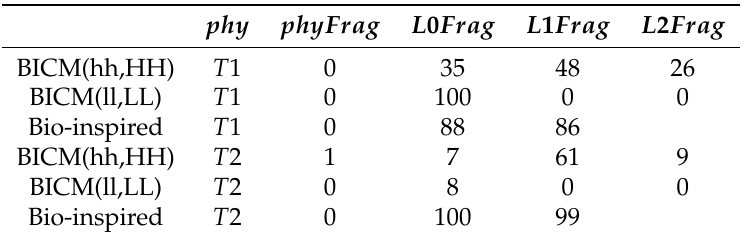
Table 7. Number of trials in which the virtual or physical topology becomes fragmented when nodes are removed by targeted attack.